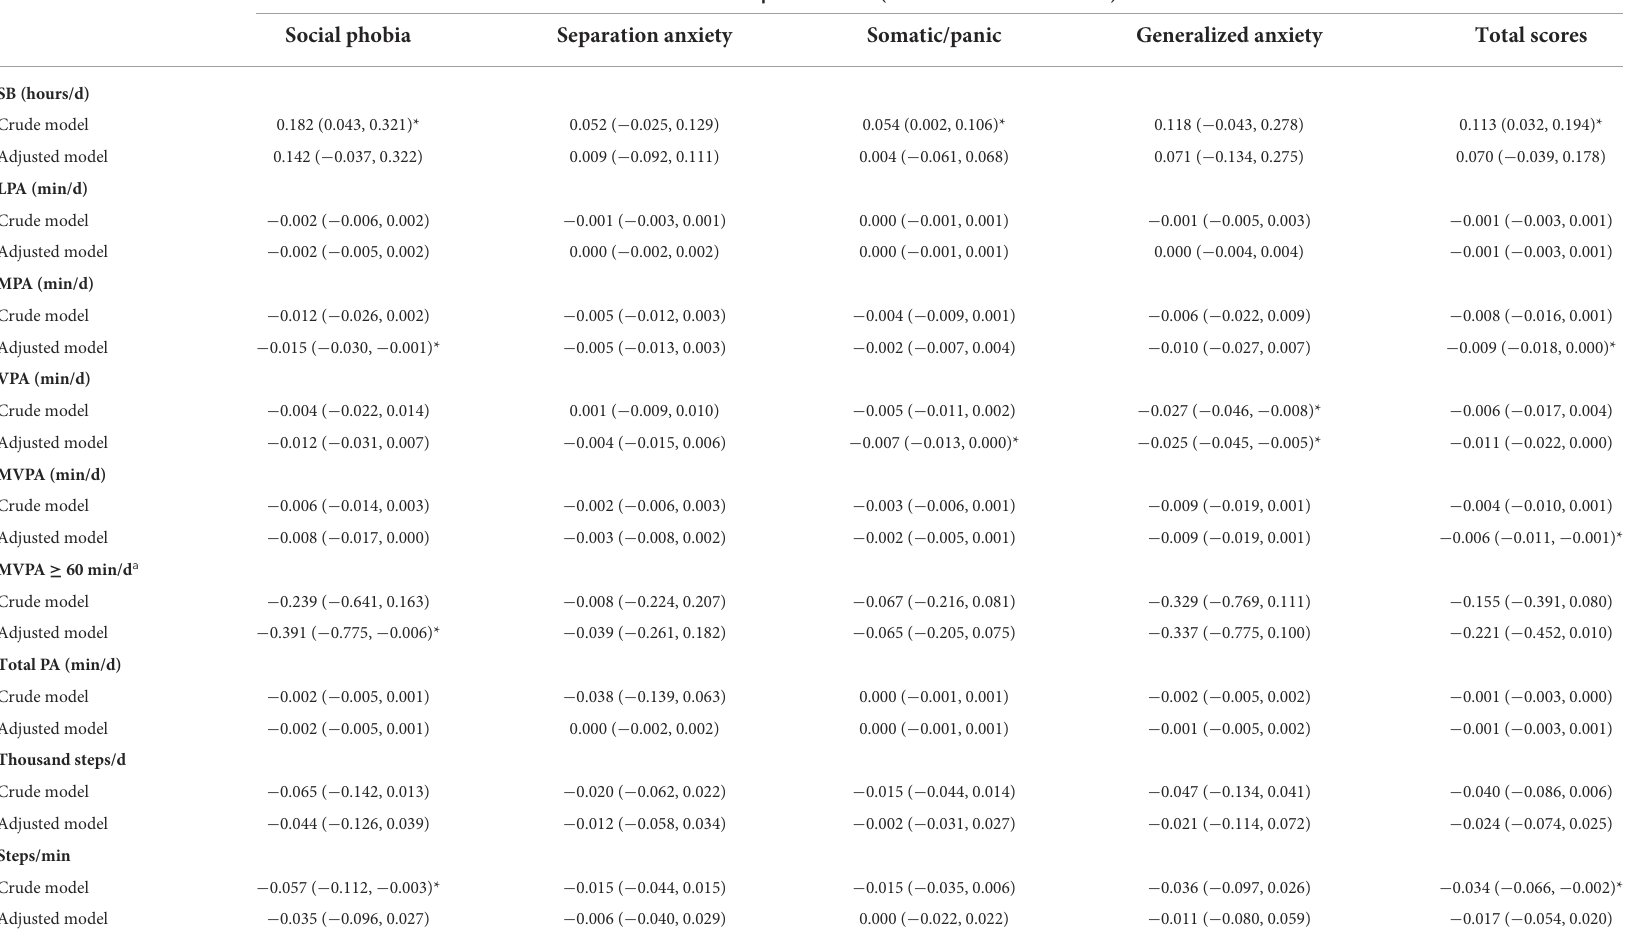
SCARED,screenforchildanxietyrelatedemotionaldisorders;ASD,autismspectrumdisorder;SB,sedentarybehavior;PA,physicalactivity;LPA,lowPA;MPA,moderatePA;VPA,vigorousPA;MVPA,moderate-to-vigorousPA. Crudemodel:noadjust.Adjustedmodel:adjustedforage,gender,severityofASDsymptoms,intellectualfunctioning,dailyaccelerometerweartime,maternalage,maternaleducationallevelandmonthlyper-capitaincome. a ComparedtoMVPA < 60 min/d. * Statisticallysignificantassociations(p <